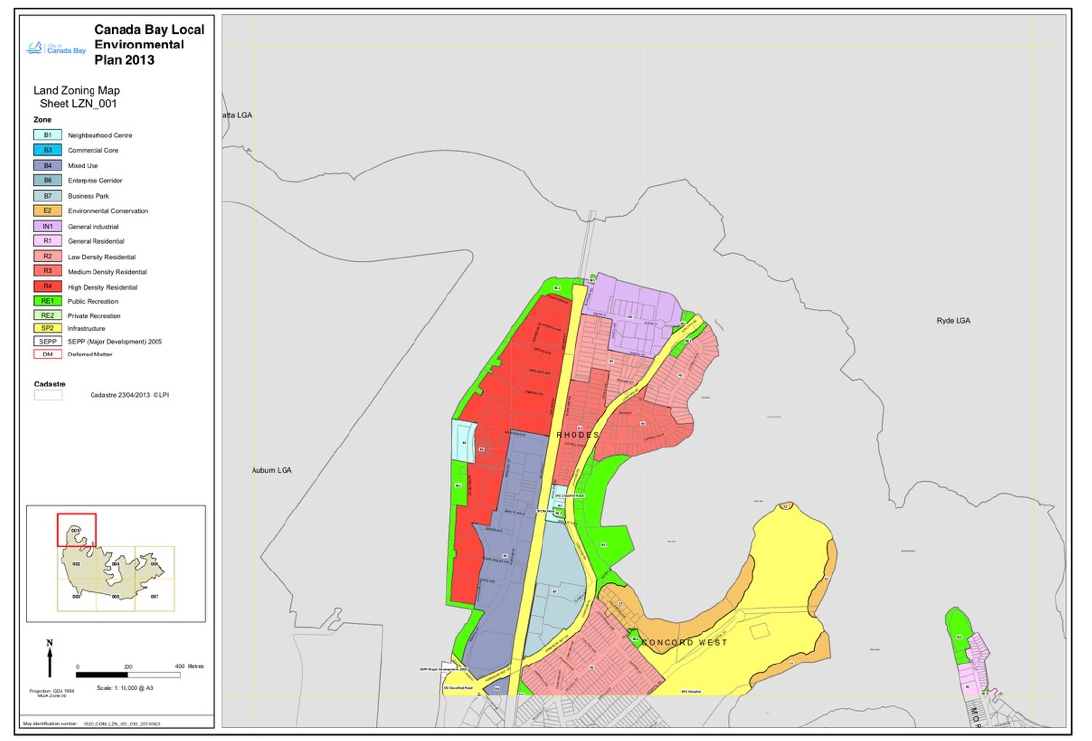
Figure A10. Rhodes Land Zoning Map LEP.